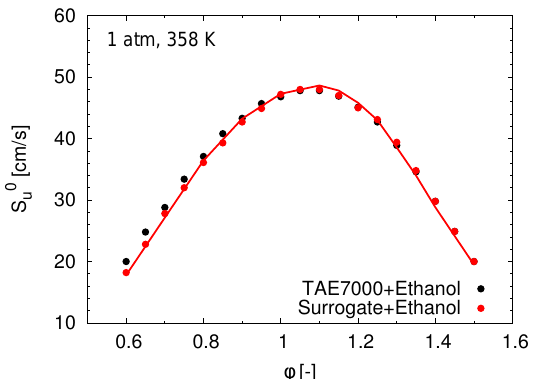
Figure A1. Burning velocities of a commercial gasoline TAE7000and its surrogate (13.7% n-heptane, 42.9% iso-octane, 43.4% toluene) with air mixtures with 15% ethanol addition. Symbols denote the experimental measurements by Dirrenberger et al. [47] at 1 atm and 358 K. Solid lines show the numerical results for the present kinetic model. Comparison analogous to that presented by the authors in [31].